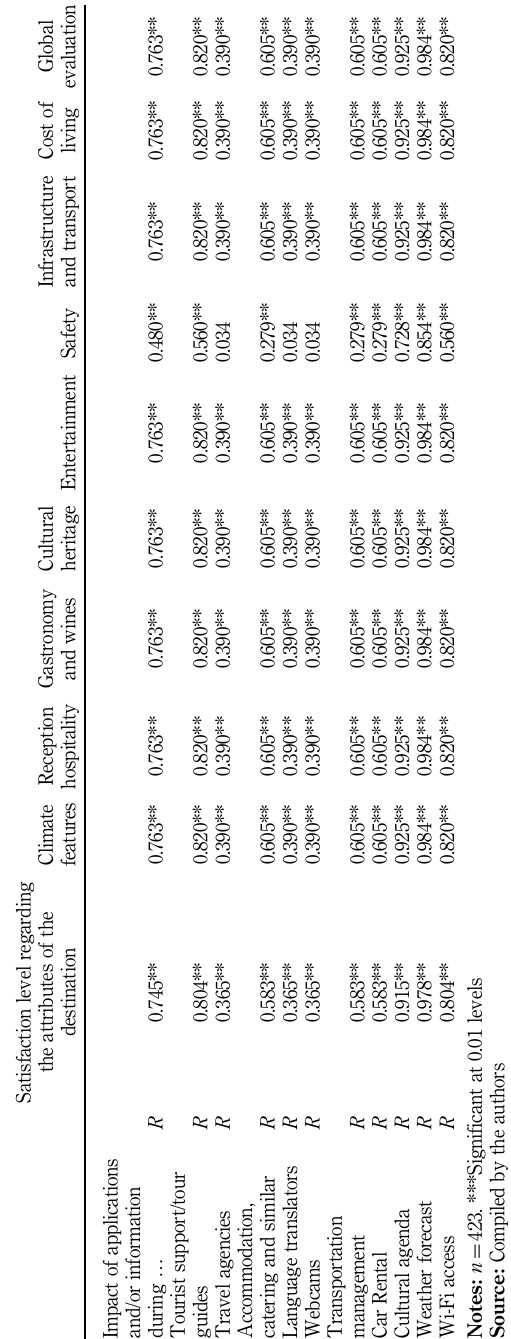
Table XII. Pearson ’ s